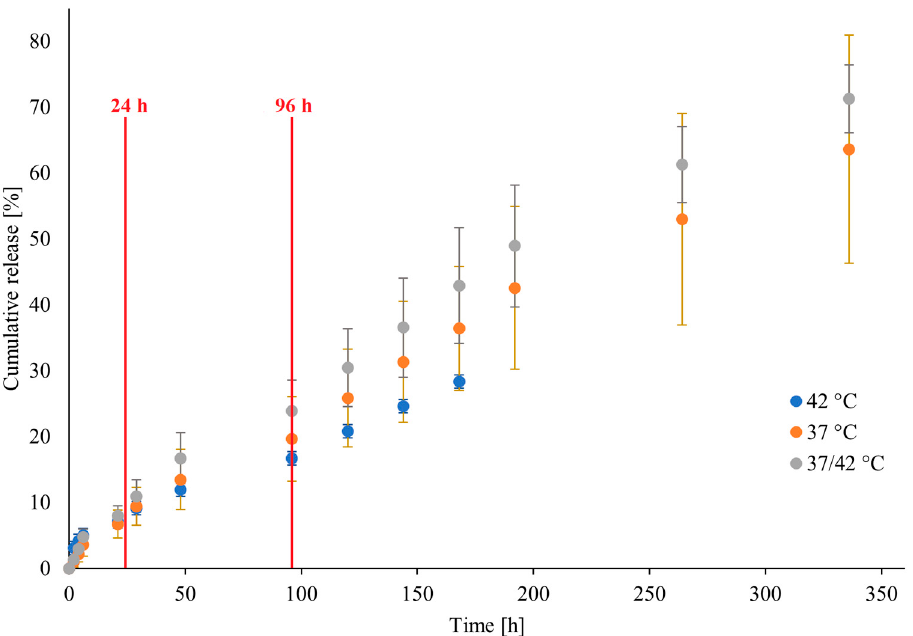
Figure 13. Drug release profiles recorded in 42 ◦ C, 37 ◦ C and pulsatile temperature increase conditions (37/42 ◦ C). Red vertical bars represent the simulated hyperthermia events. Each sample was prepared in triplicate. The data points were presented as cumulative release ± SD (n=3).